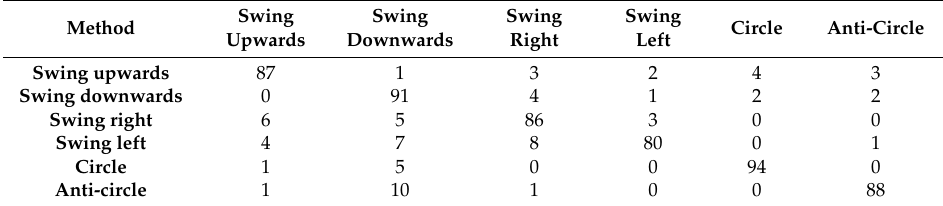
Table 2. Confusion matrix for 3D gesture recognition by leave-one-subject-out cross-validation.